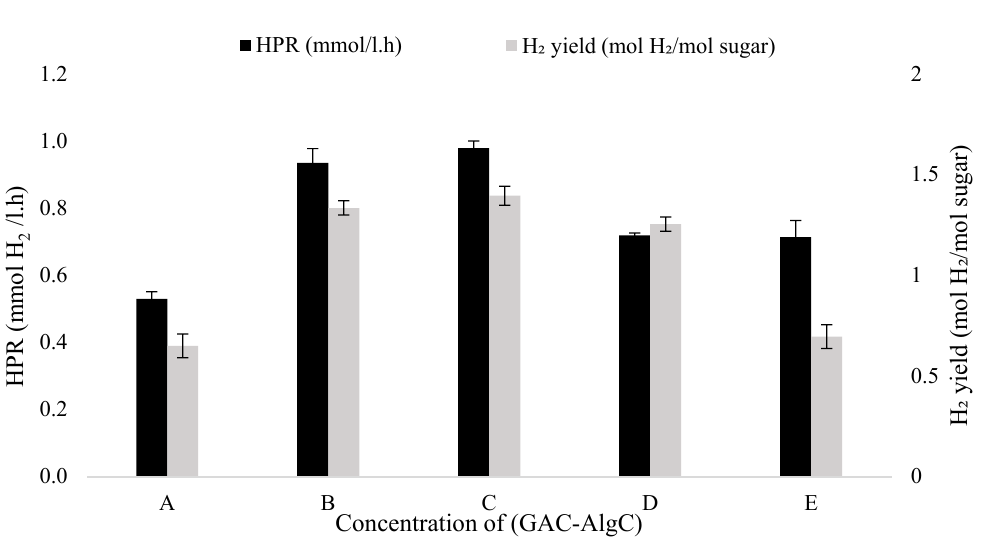
Figure 5. Hydrogen production (mL) at different concentrations of chitosan in 200 mL of a 250 mL modified bioreactor in batch fermentation.